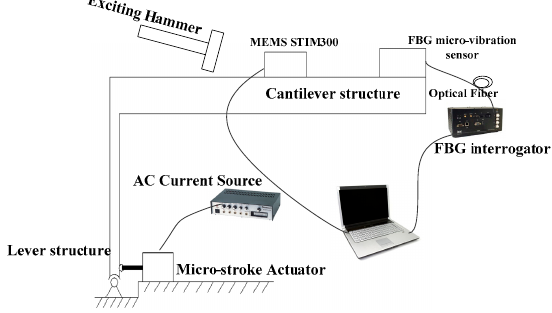
Figure 11. The principle diagram of the micro-vibration simulation experiment system.